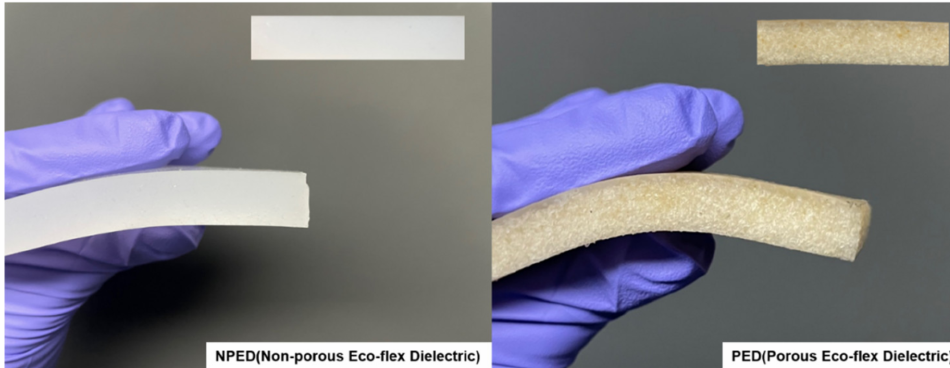
Figure 9. The appearance of manufactured NPED and PED.